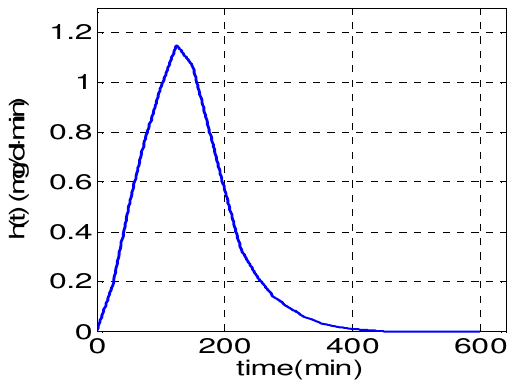
Fig. 3. Disturbance meal function (exogenous glucose